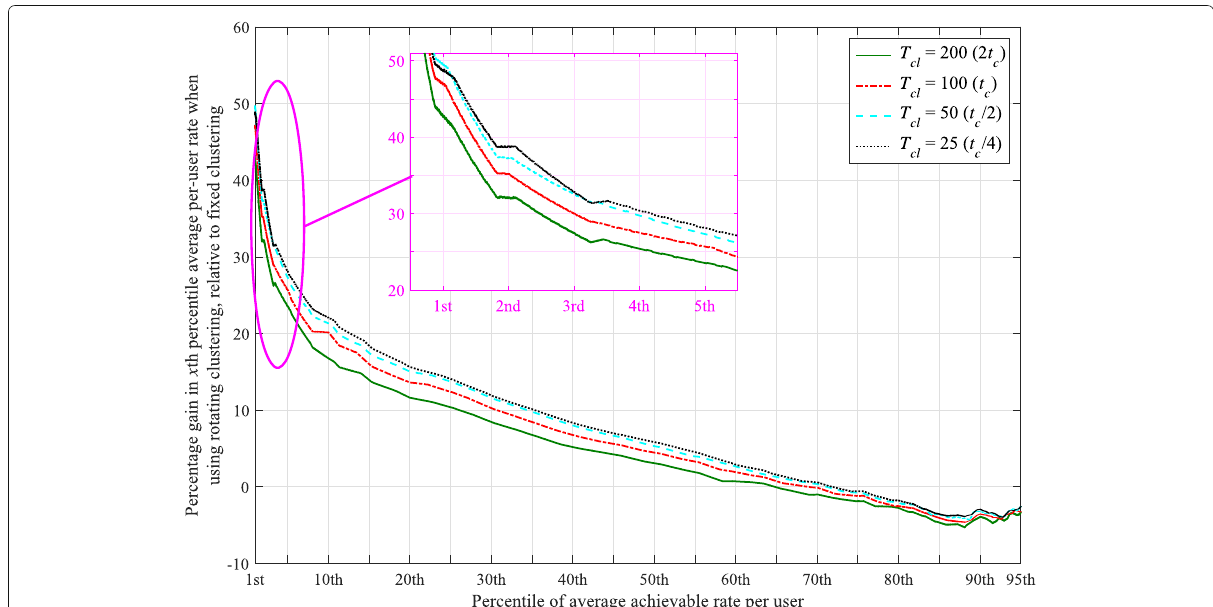
Fig. 4 Comparison of percentage gain in the x th percentile average achievable rate per user of the rotating clustering scheme relative to fixed clustering, for different rotation speeds and using proportionally fair (PF) scheduling in the six-cell layout. Other parameters are the same as in Fig.